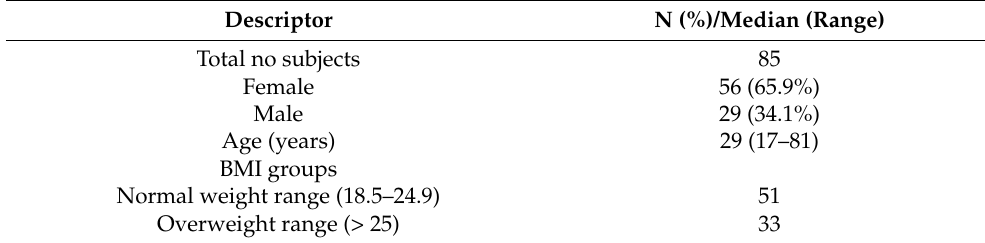
Table 1. Demographic characteristics of the study group.